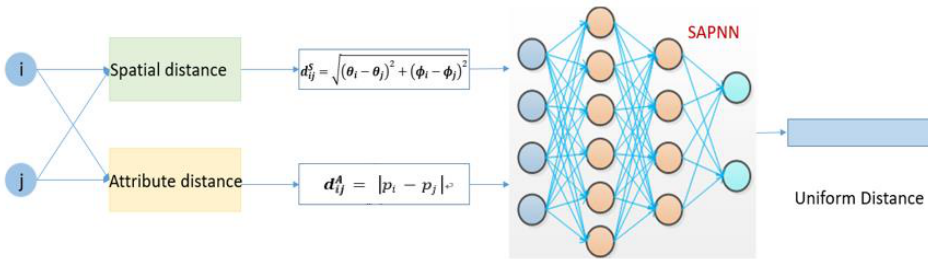
Figure 2. The structure of SAPNN.